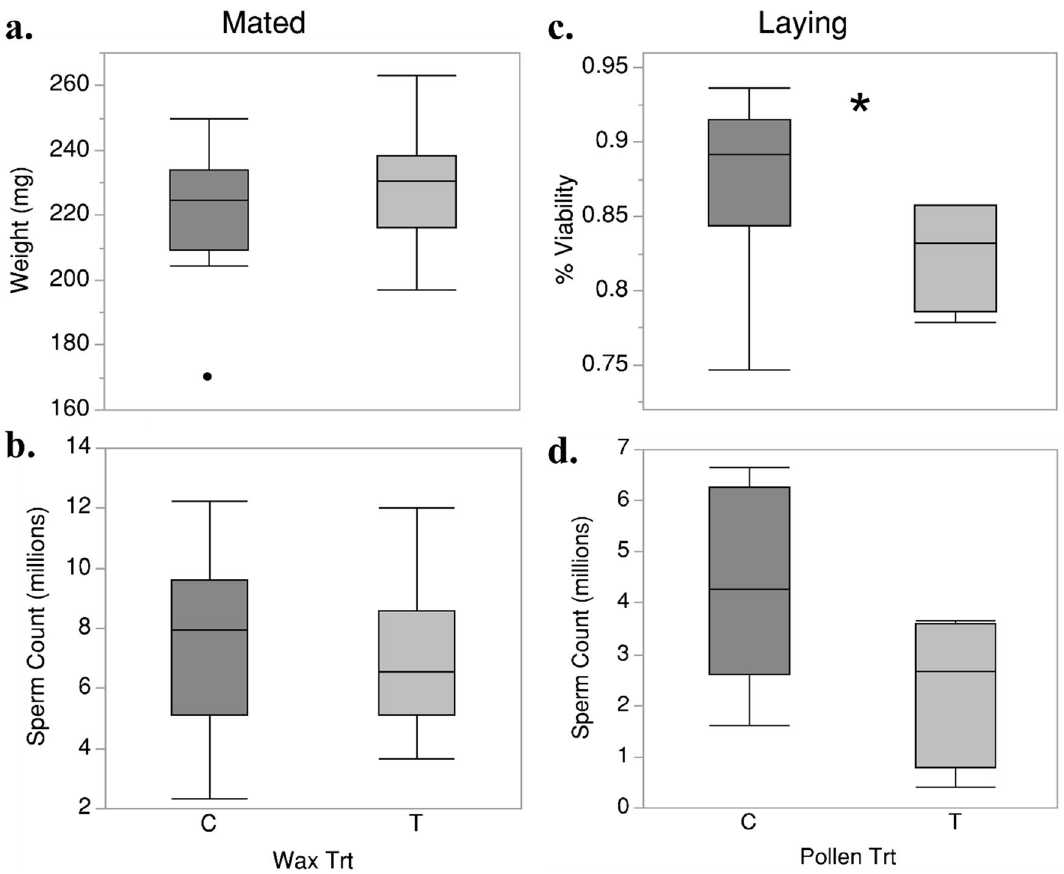
Figure 4. A comparison between queens reared treated (T) and control (C) wax cups and colonies, * P < 0.05. Mated queens are those which were sampled following the initiation of egg laying ( a , b ) (Control, n = 18. Treated n = 17). Laying queens were those sampled at the end of the colony growth period ( c , d ) (Control, n = 14; Treated n =